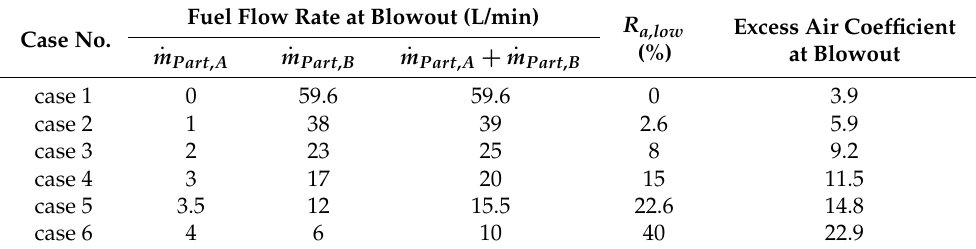
Table 1. Blowout excess air coefficient at different fuel distribution ratios. Case No.